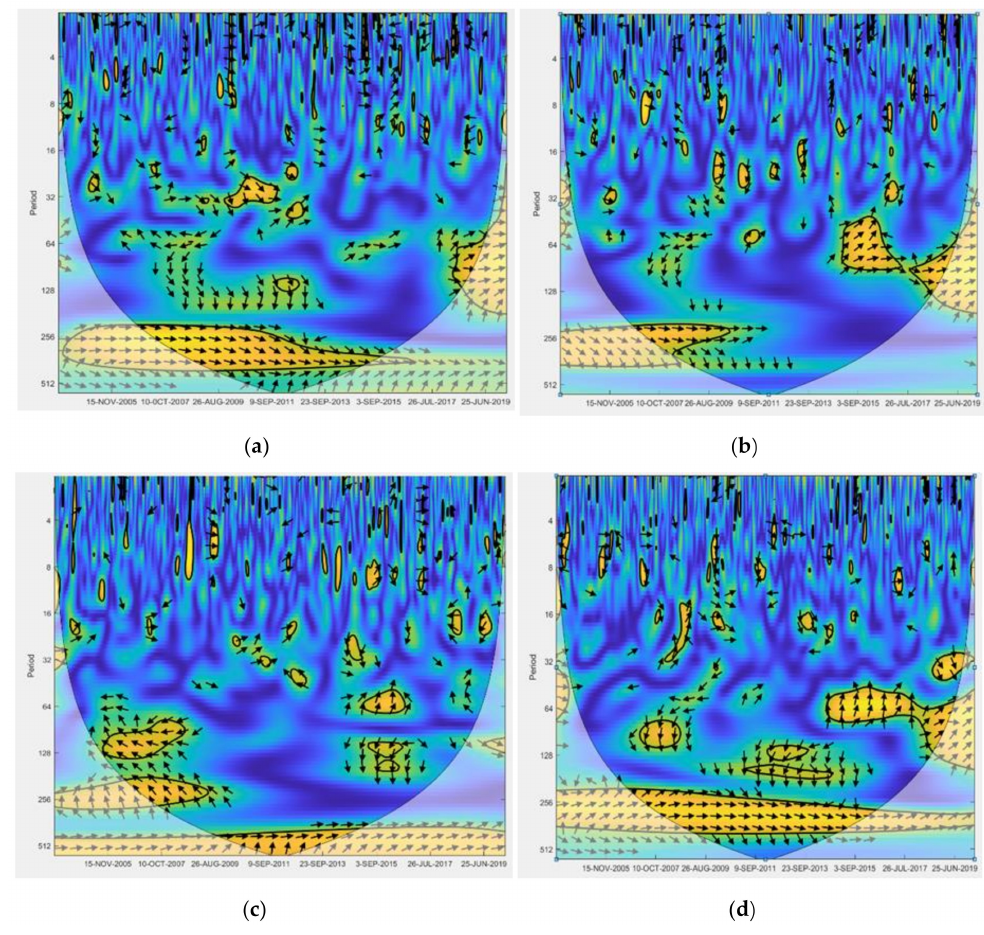
Figure 4. The co-movement between the oil and stock markets in the time-frequency space in the context of panic. ( a ) US stock market, SP500; ( b ) Japanese stock market, N225; ( c ) mainland China’s stock market, SSEC; ( d ) Hong Kong stock market,